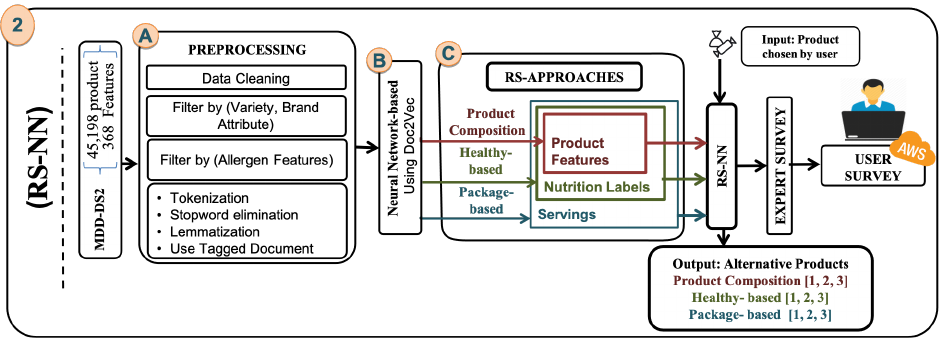
Figure 4. The modeling methodology for RS-NN.